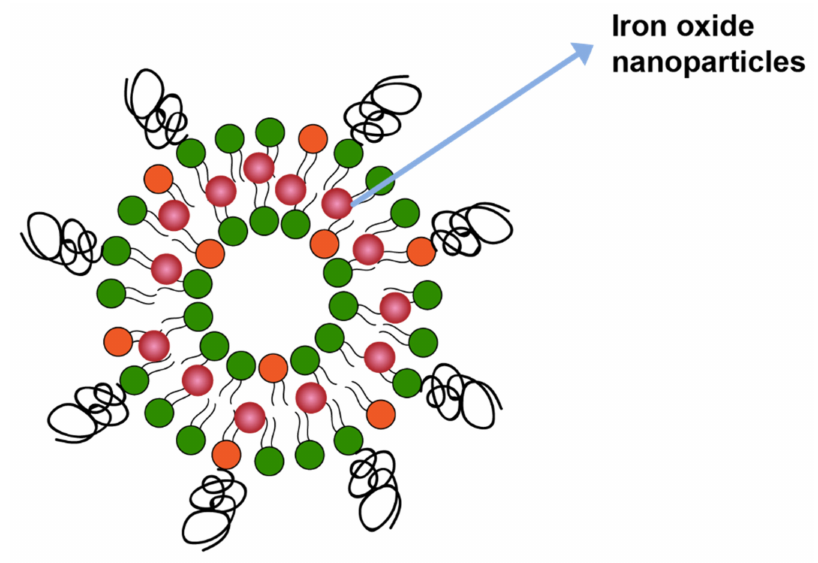
Figure 11. Iron oxide nanoparticles incorporated in lipid